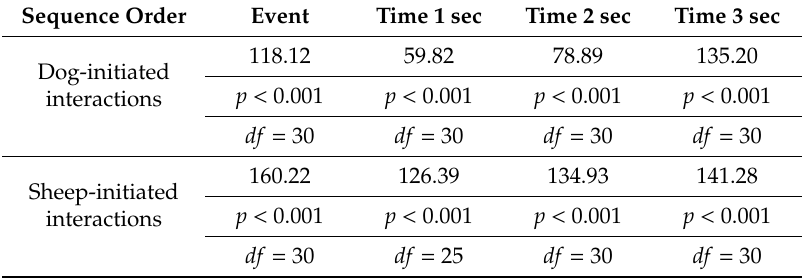
Table A8. Maximum likelihood-ratio chi-squared statistic ( G 2 ) for event-based and each time-based lag sequential analysis for dog-initiated and sheep-initiated behavioural